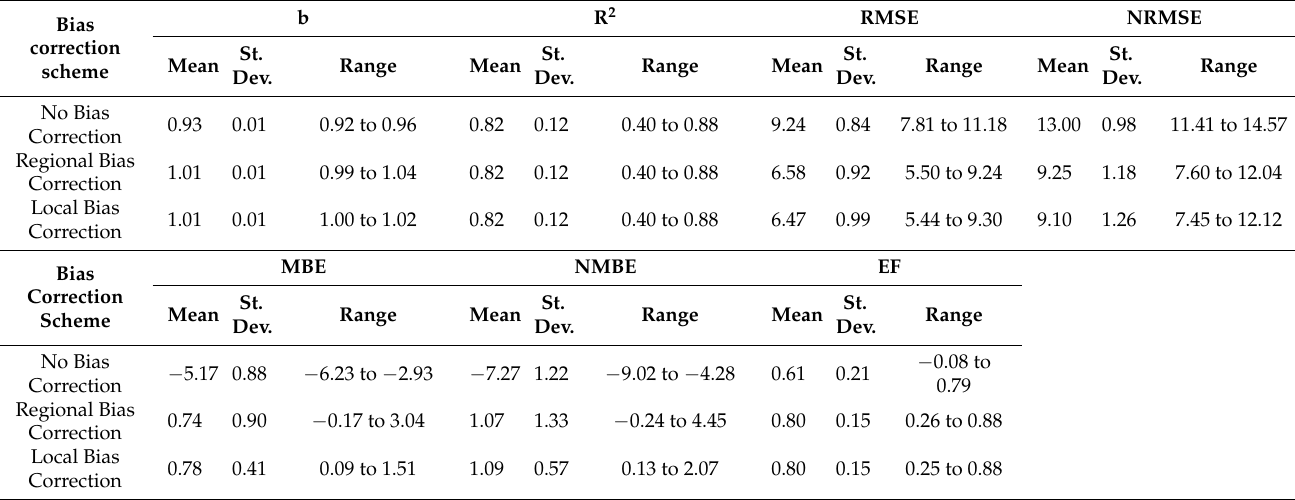
Table 7. Mean and range values of the accuracy metrics relative to NASA POWER relative humidity with and without bias correction for the full data set of all 14